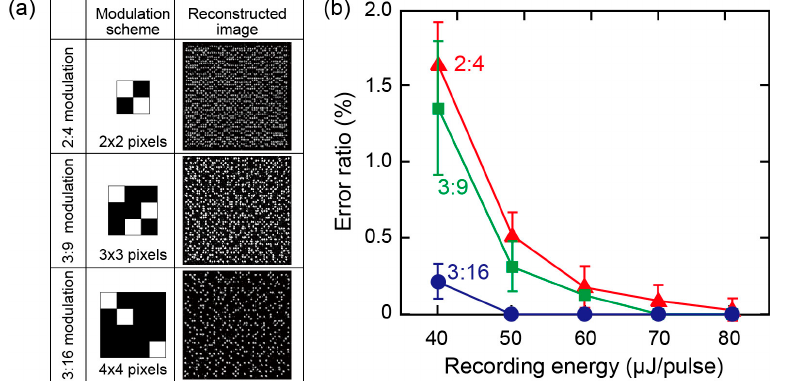
Figure 5. ( a ) Modulation schemes and example of reconstructed images recorded at 80 µJ encoded with 2:4, 3:9, and 3:16 modulation schemes. Each reconstructed signal pattern consists of 64 × 64 pixels. ( b ) The error ratio in reconstructed images for the three modulation schemes [30].